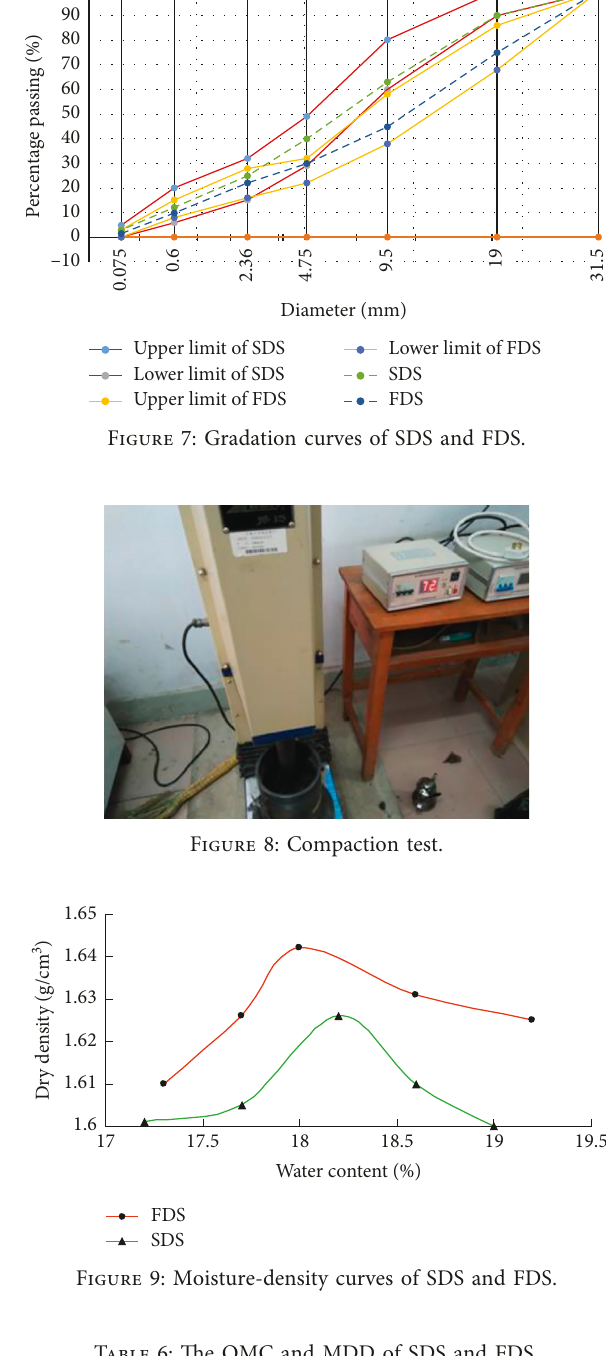
Table 7: The experimental programme.